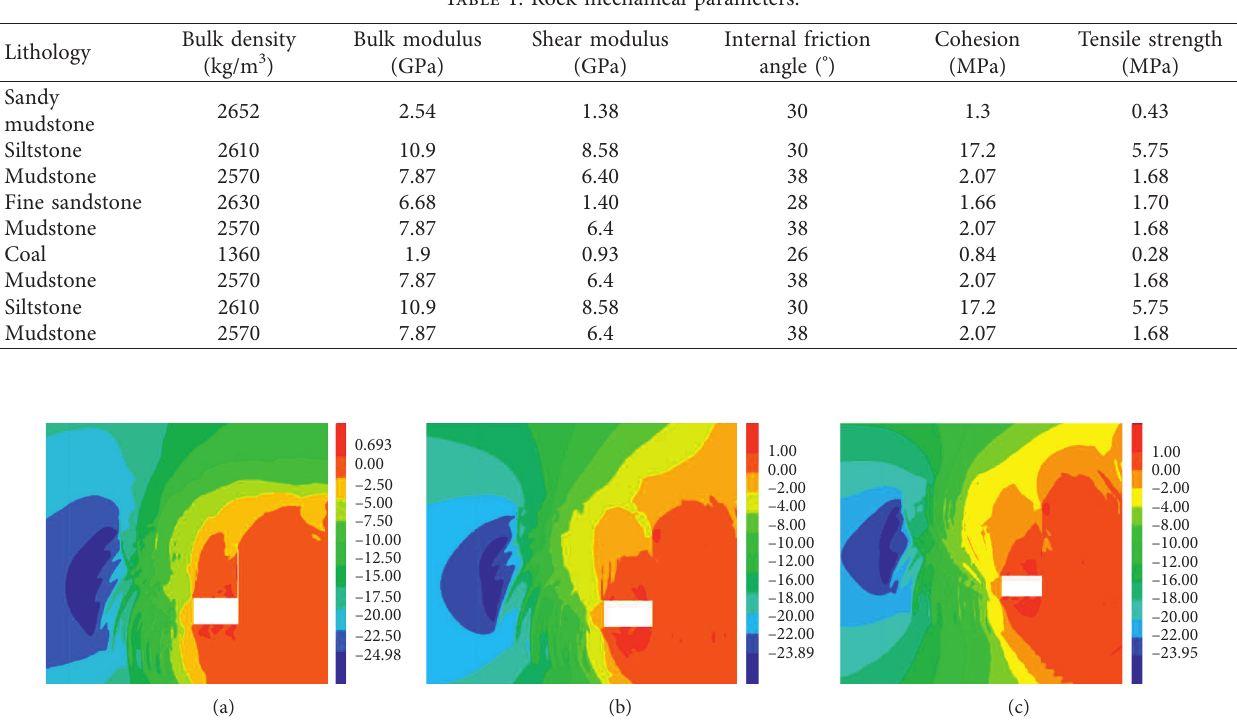
Figure 5: Vertical stress distribution under different roof cutting heights (MPa). (a) Roof cutting height of 6 m. (b) Roof cutting height of 8m. (c) Roof cutting height of 10m.